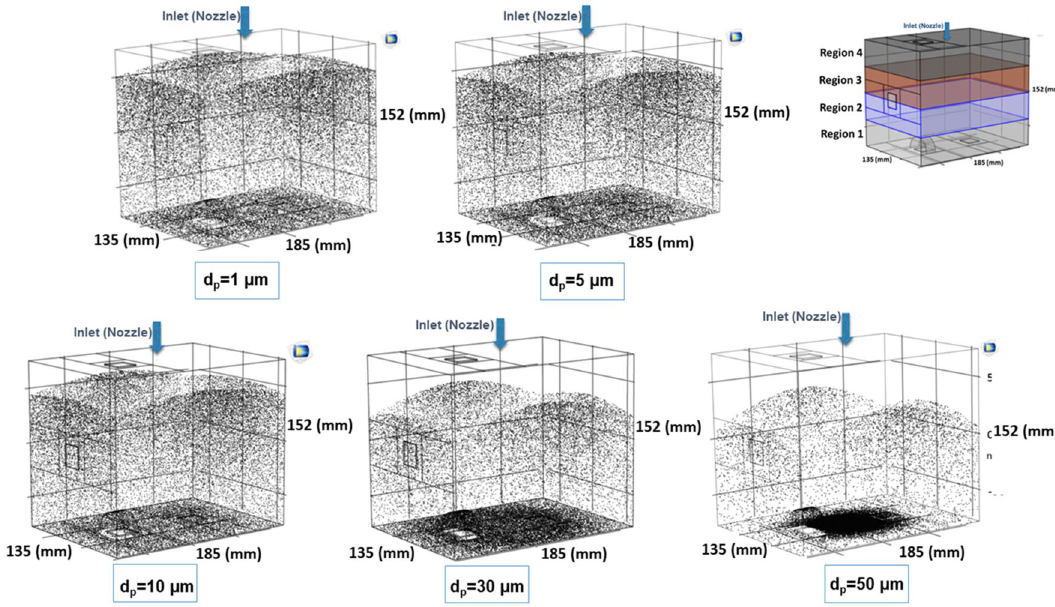
Figure 7. Nebulization of black ink at a flow rate of 0.5 mL s −1 for different aerosol droplet diameters using CFD. The black dots display the aerosol droplets.